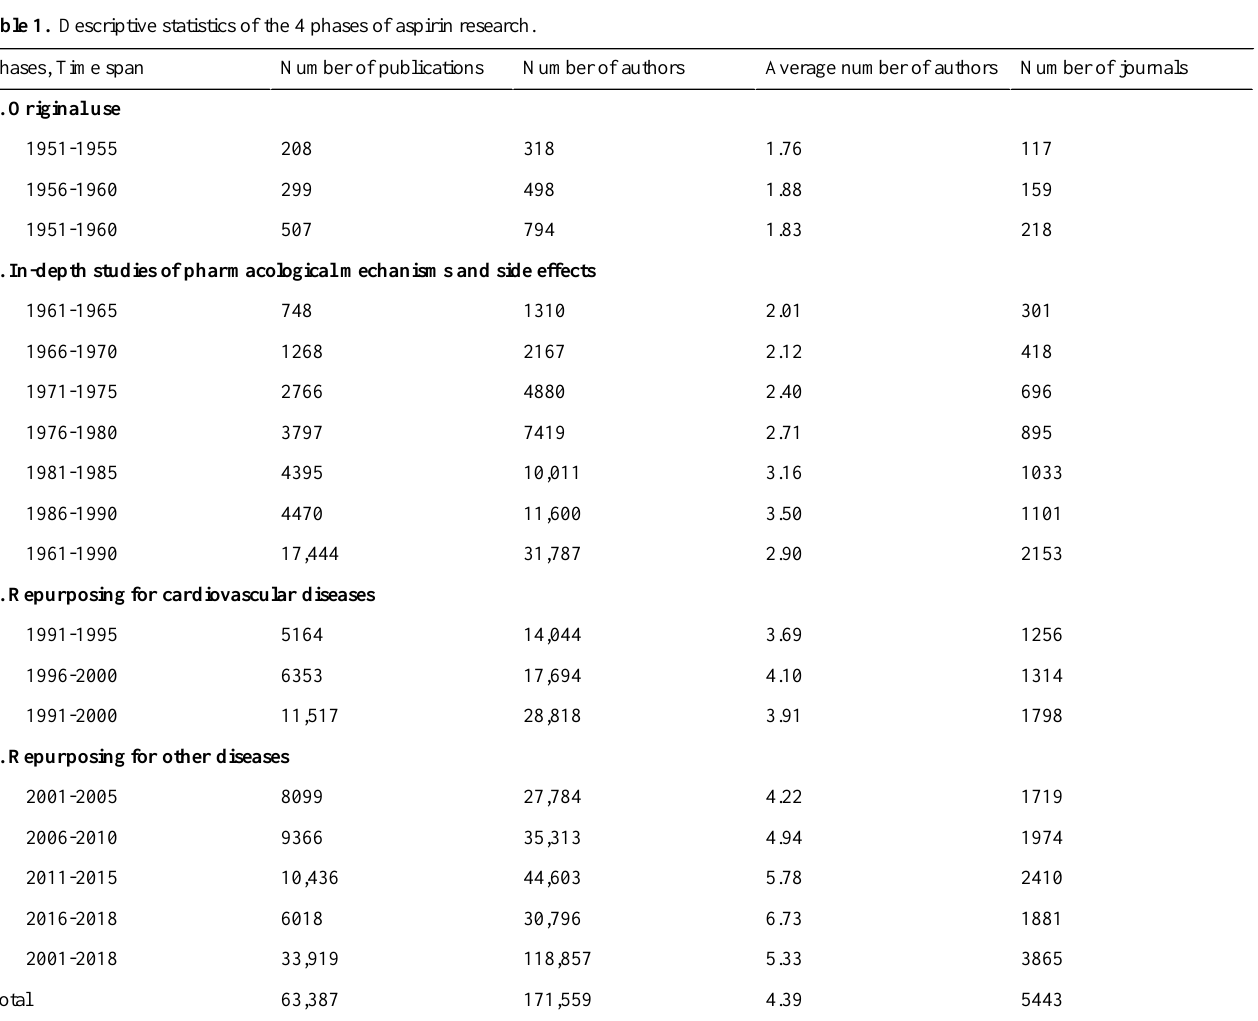
Table 1. Descriptive statistics of the 4 phases of aspirin